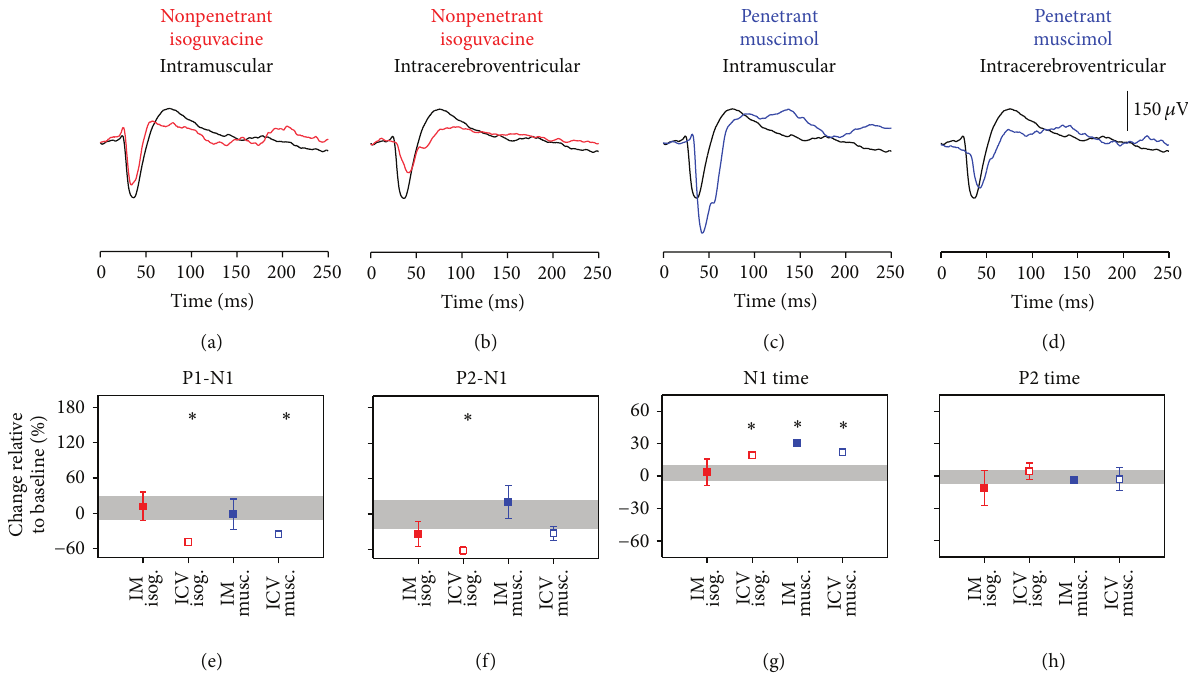
Figure 4: Cortical electrophysiology following anaesthetised isoguvacine/muscimol dosing. VEP responses in animals ((a)–(d), 𝑛 = 5 for each drug group) at anaesthetised baseline (black lines, average of anaesthetised groups) compared to (a) intramuscular and (b) intravitreal isoguvacine (red) and (c) intramuscular and (d) intravitreal muscimol (blue). (e)–(h) summarise VEP parameters (average ± SEM) following isoguvacine or muscimol injections via different routes (see method for details). Grey areas indicate 95% CI of the particular VEP parameter in all anaesthetised baseline recordings. ∗ 𝑝 < 0.05